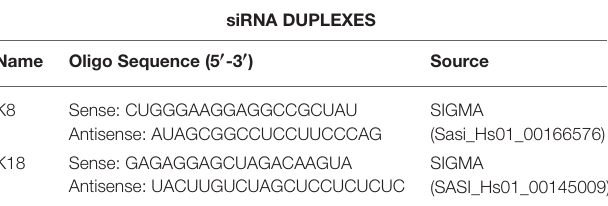
TABLE 2 | Sequences of siRNA duplexes used in this